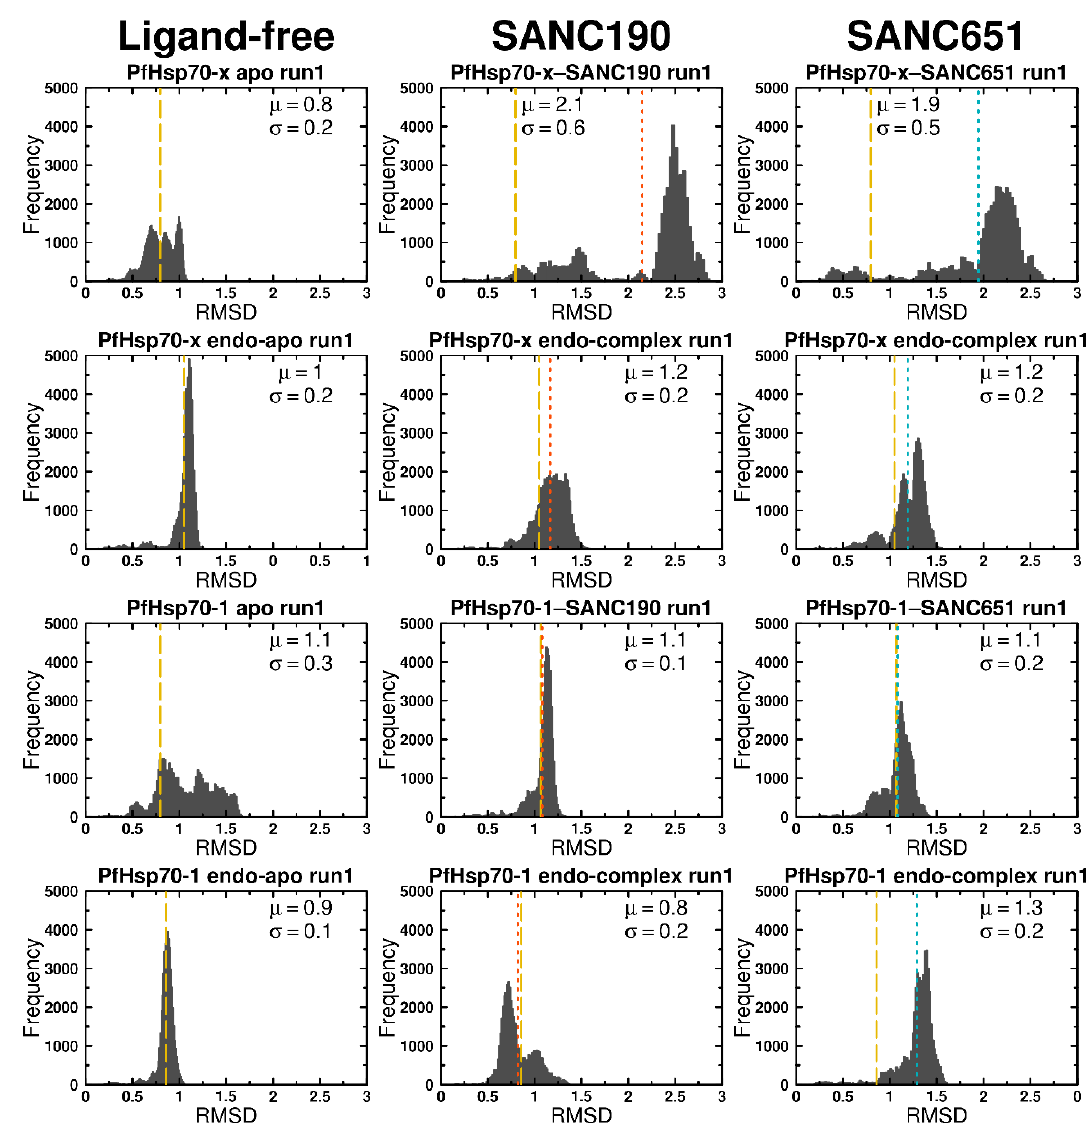
Figure 3. Violin plots showing the kernel probability density distribution of protein backbone RMSDs per MD run. Density traces were plotted symmetrically to the left and right of boxplots. The width is proportional to frequency of occurrence. The overlaid boxplots highlight data range and the distribution spread. The vertical inside line represents the median value. The bars range from 25 th (bottom) to 75 th (top) percentile. µ denotes the calculated RMSD mean value.